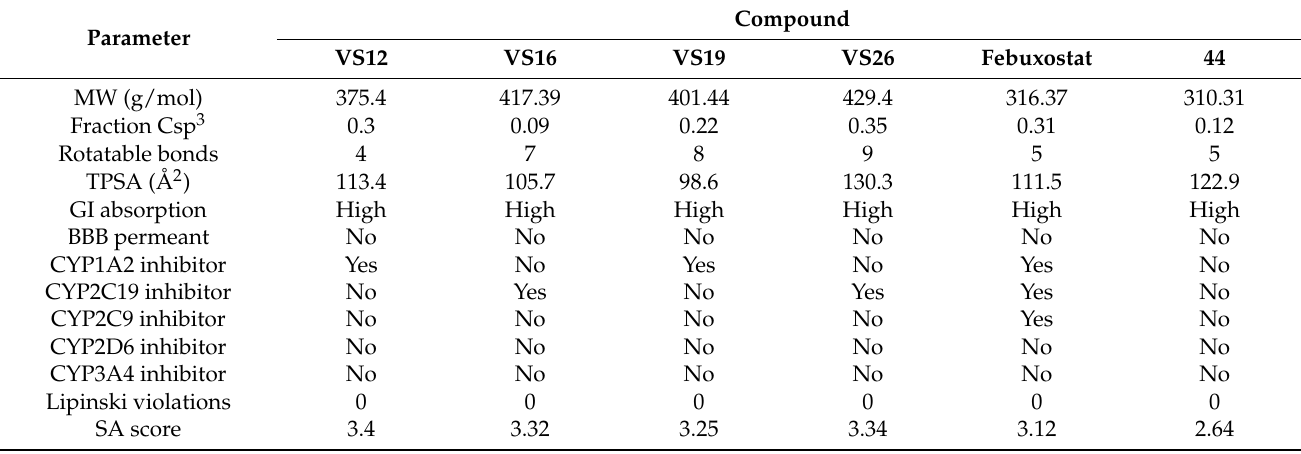
Table 5. The ADME prediction results of the virtual-screened hits ( VS12 , VS16 , VS19 , and VS26 ), compound 44 , and febuxostat. Compound Parameter VS12 VS16 VS19 VS26